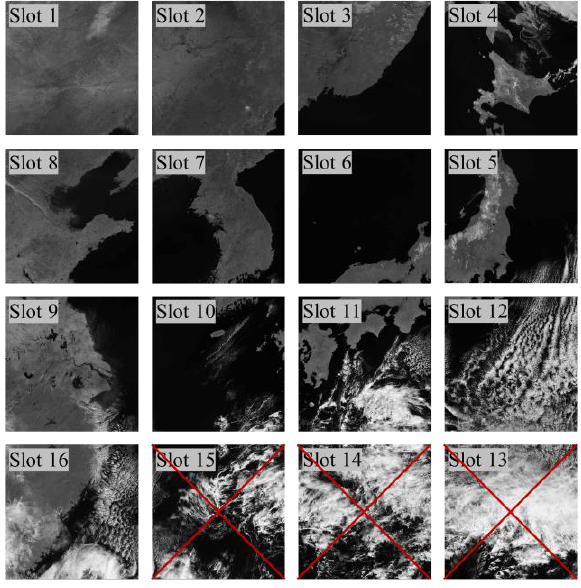
Figure 6. Experiment GOCI Slot image